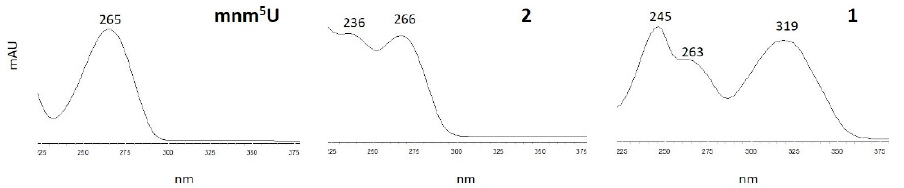
Figure 2. In-line UV-visible spectra (220–400 nm) of Figure 2: 5-methylaminomethyl uridine (mnm 5 U) (Rt = 19 min), 2 (Rt = 21 min), and 1 (Rt = 24 min).